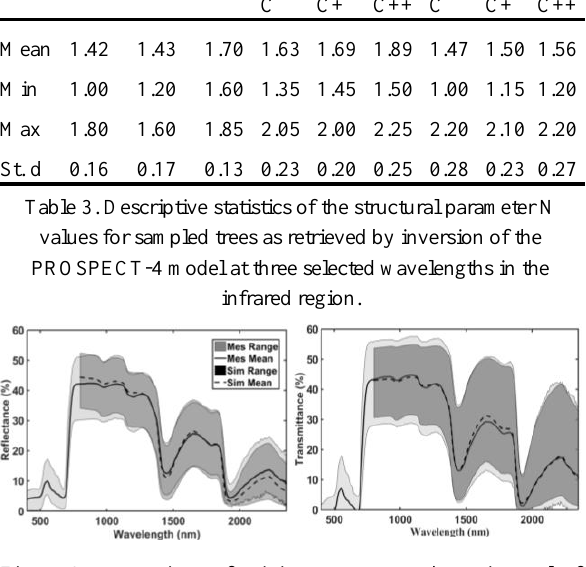
Figure 3: comparison of minimum, mean and maximum leaf reflectance (left) and transmittance (right) of measured (Mes) and PROSPECT simulated (Sim) spectra for all 137 samples collected in the mixed mountain forests of the Bavarian Forest National Park.